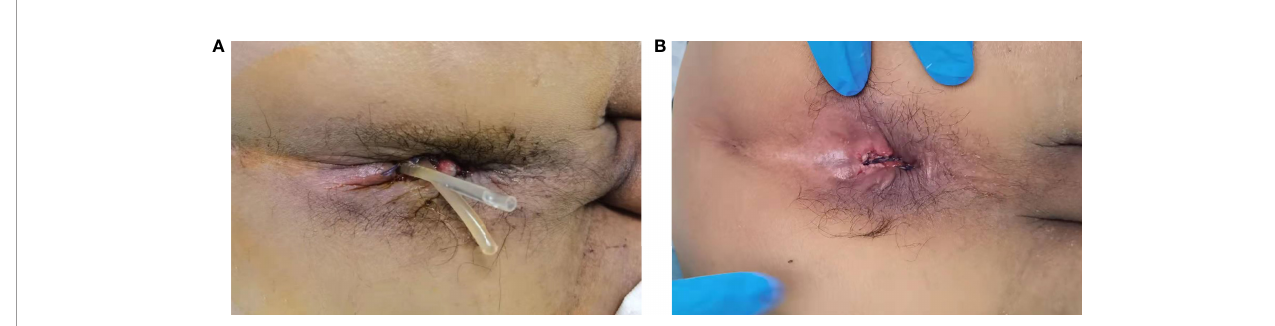
FIGURE 1 | (A) , External appearance of the anus after the placement of trans-anastomotic drainage tube postoperative day 1. (B) , External appearance of the anus after removing the trans-anastomotic